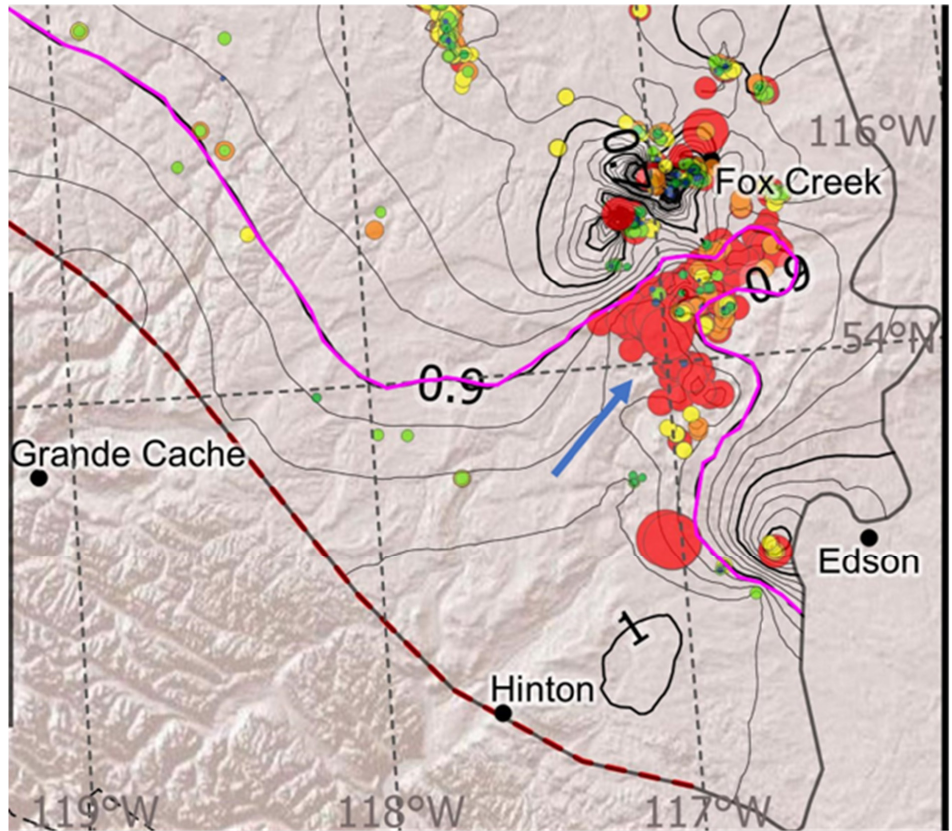
Figure 40. Expanded view of gas composition near the town of Fox Creek, Alberta. See Figure 38 for the location. The pink line highlights the drier gas composition contour of 0.9 (i.e., 90% methane composition in producing fluids). The blue arrow indicates a migration of drier gas into the Fox Creek area, as illustrated by the high concentration of large red bubble plots compared to the area north of the town of Fox Creek that contains smaller bubble plots in a variety of shades of green, blue, yellow, and orange. See Figure 38 for the scale and legend.